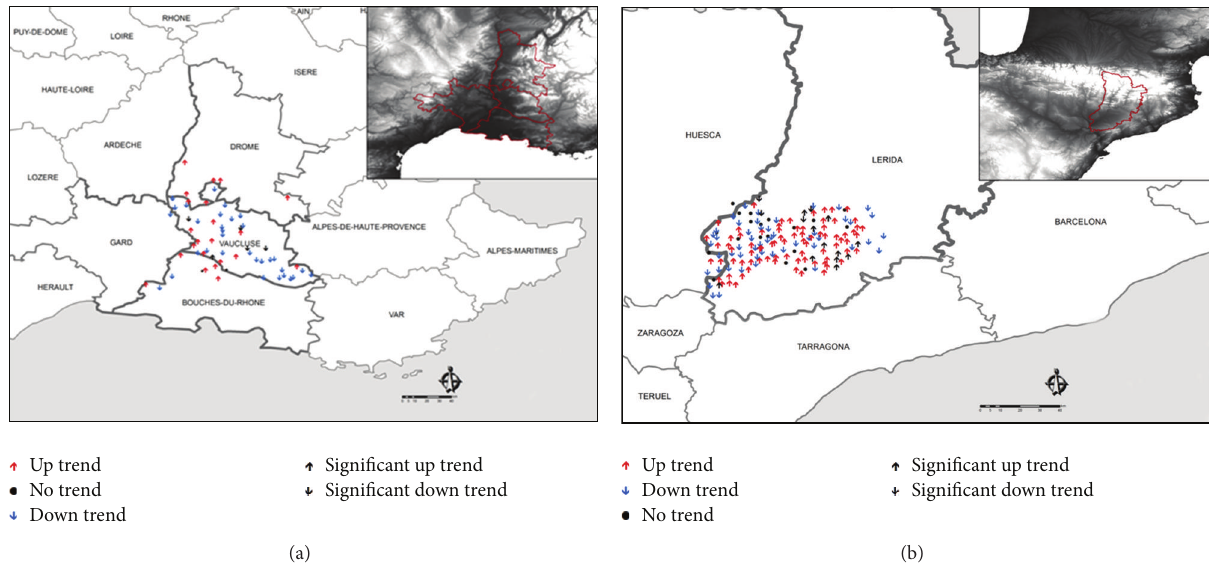
Figure 6: Geographical distribution of hailpads with upward, downward, and no trends, for the number of pads impacted from 2001 to 2010 in the Southeast of France (a), and from 2000 to 2011 in L´erida (Spain)